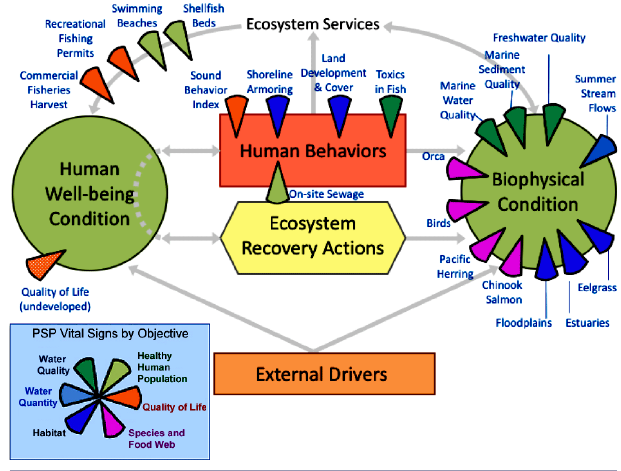
Fig. 2 . Integrated conceptual model with “wedges” demonstrating the initial vital signs prior to the study. PSP, Puget Sound